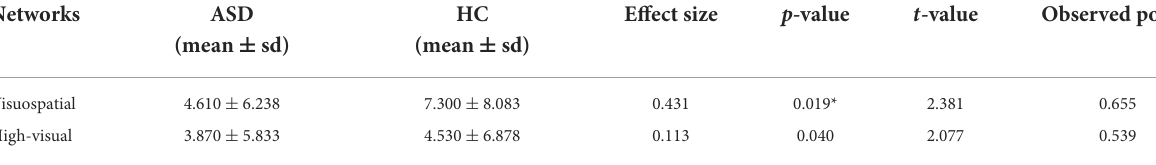
TABLE 3 Significant decreases in betweenness centrality of brain networks in ASD as compared to HC based on Richiardi et al. parcellation method.